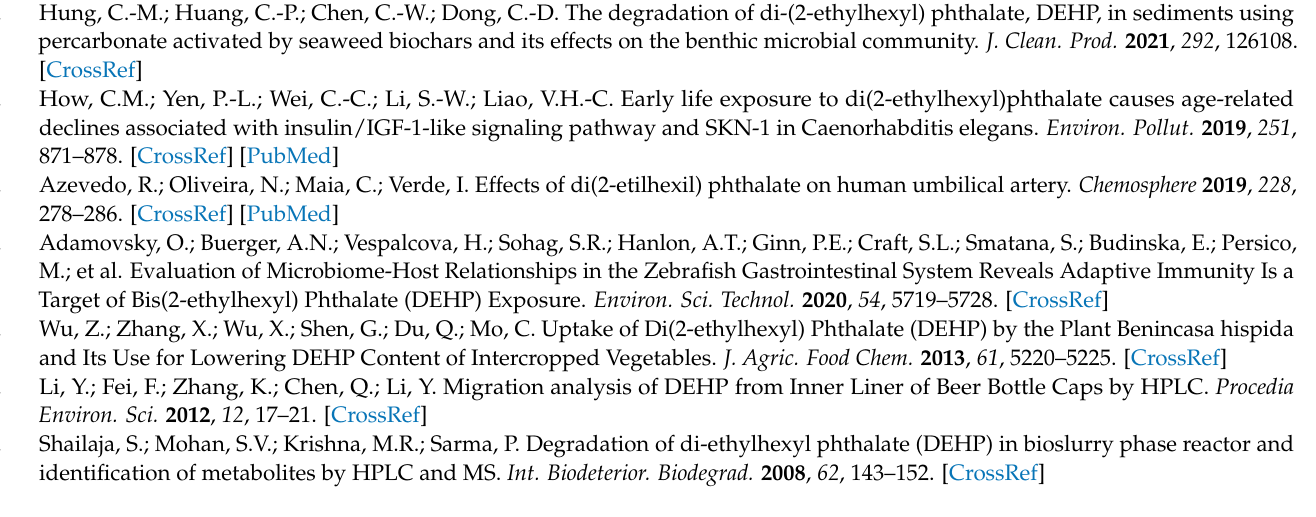
Figure S2. TEM image of SNA; Figure S3. The UV absorption spectra of AuNPs and